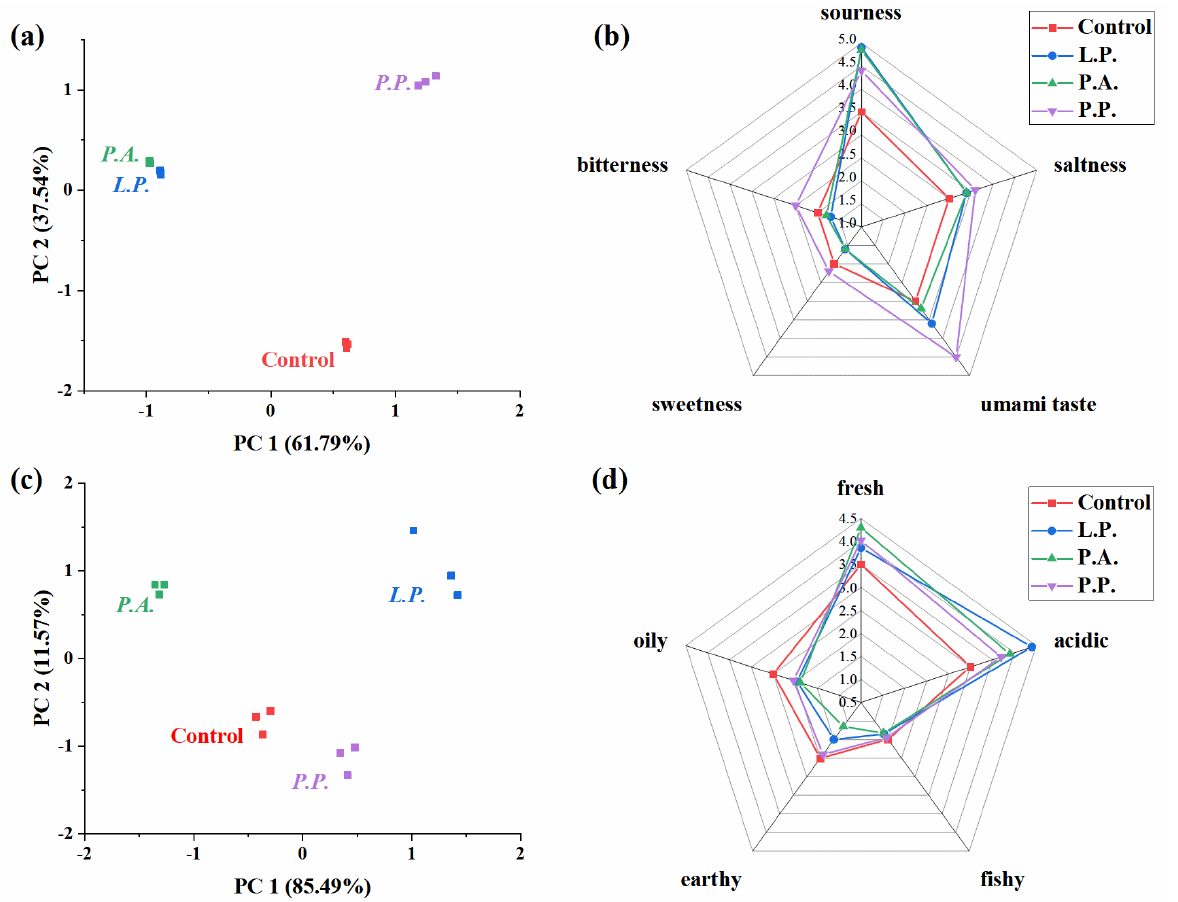
Figure 4. Principal component analysis (PCA) of Zhayu samples fermented with different starter cultures based on E-tongue results ( a ) and E-nose results ( c ), and sensory evaluation of taste charac- teristics ( b ) and odor profiles ( d ) of Zhayu products prepared with different kinds of LAB. Table 2. Contents (mg/100 g) and taste activity value (TAV) of free amino acids in Zhayu